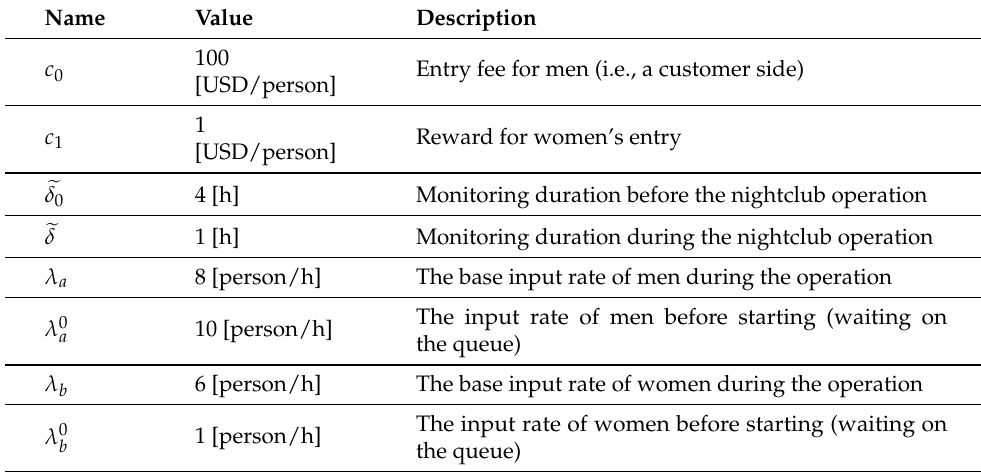
Table 2. Initial conditions of the Khaos